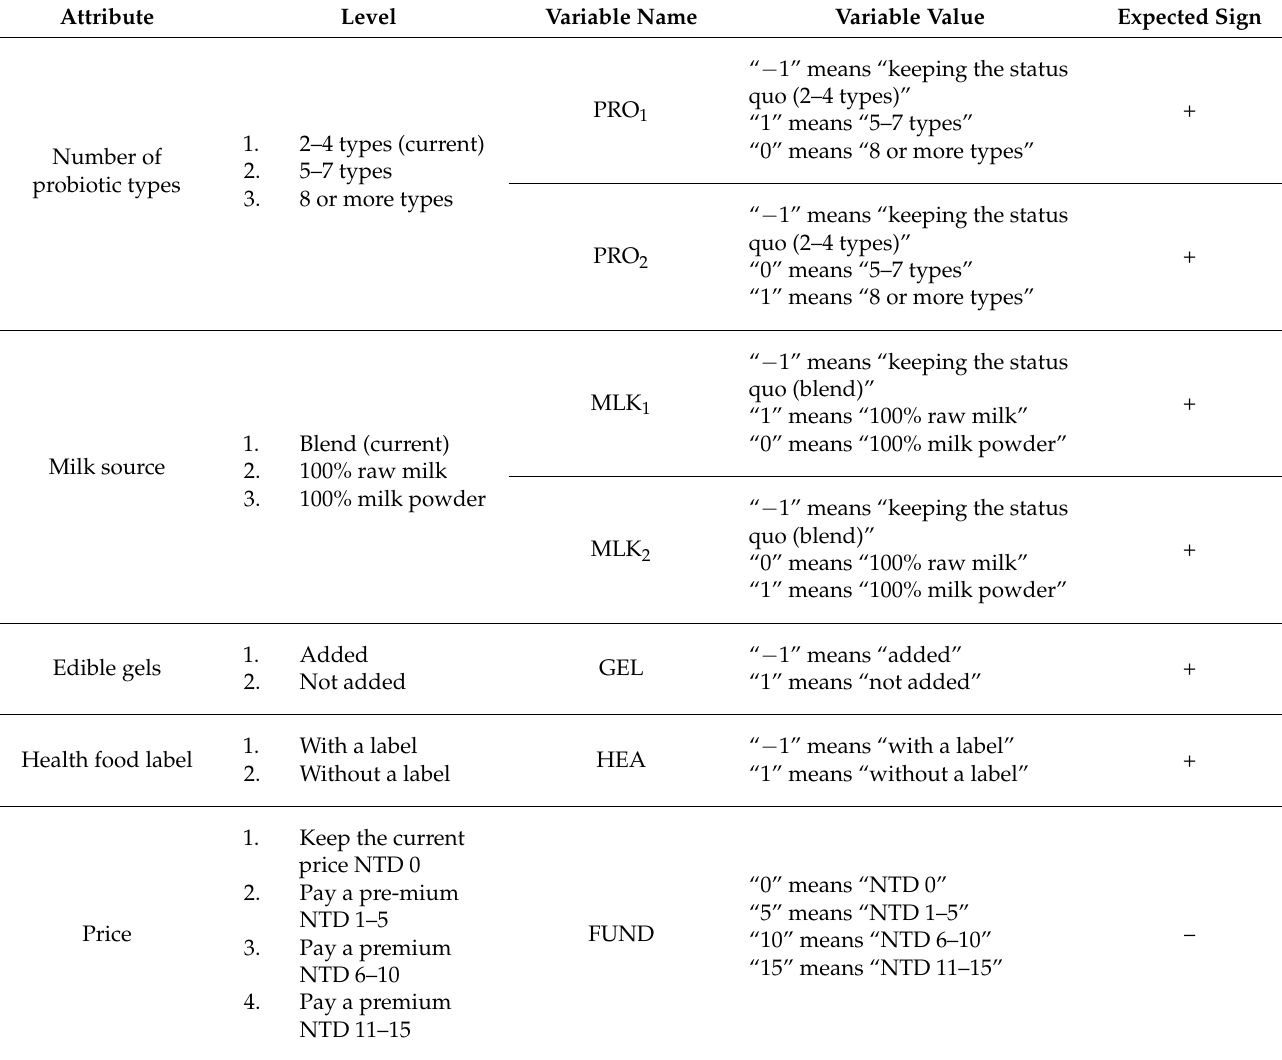
Table 1. Yogurt attributes and their